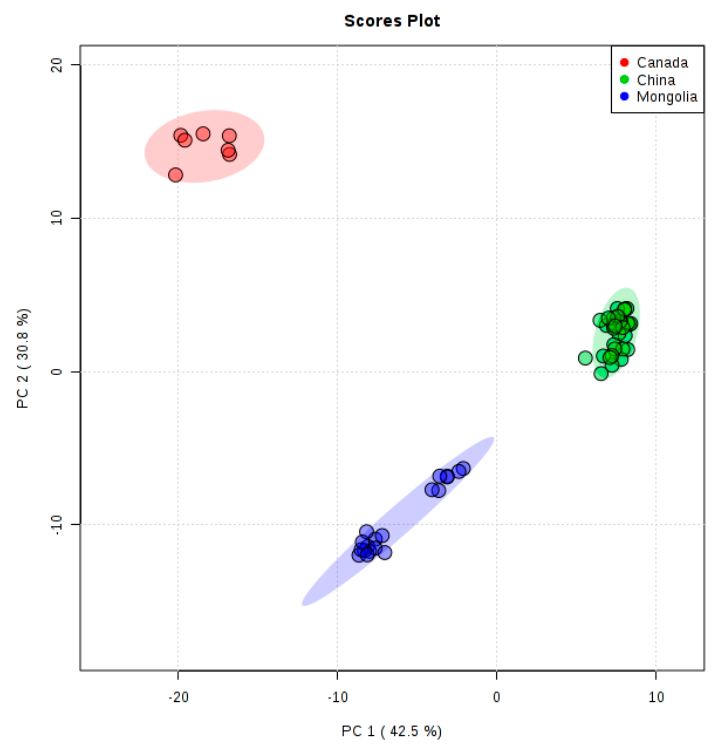
Figure 1. Principal component analysis (PCA) scores plot for rapeseed collected from China (green), Canada (red), and Mongolia (blue). The distinct separation of Chinese, Canadian, and Mongolian rapeseeds indicates the presence of metabolites with significant difference.